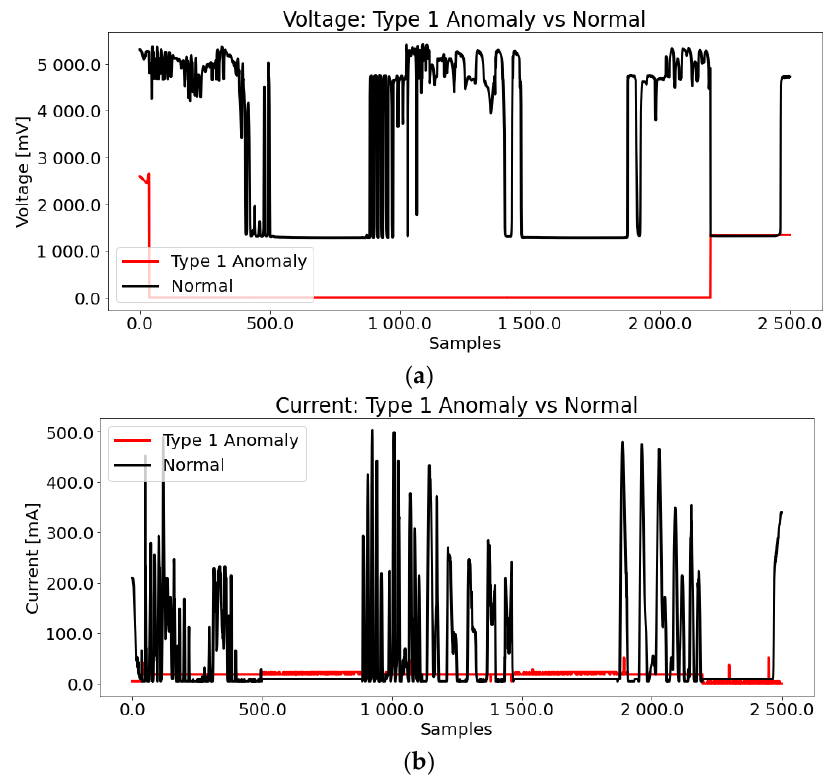
Figure 6. Type 1 anomalies in ( a ) voltage and ( b ) current